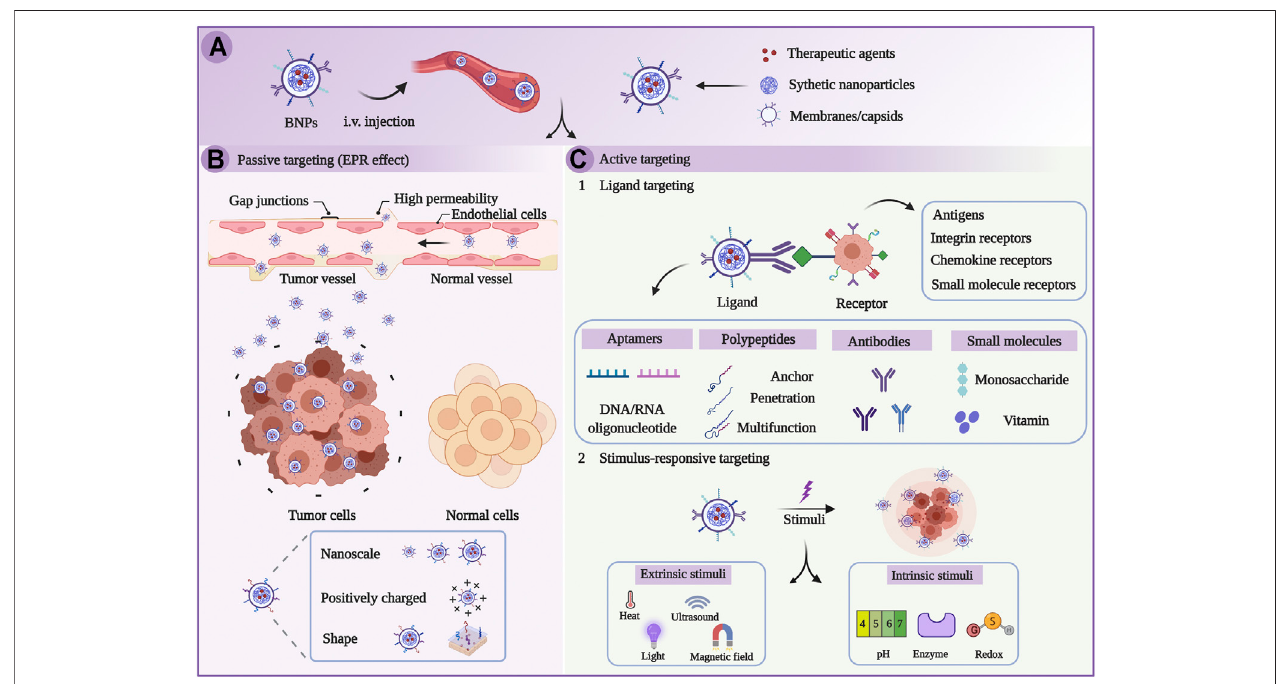
FIGURE 2 | Schematic illustration of targeted therapy on the basis of biomimetic nanoparticles (BNPs). (A) BNPs were injected intravenously. (B) BNPs passively target tumors through EPR effects. (C) BNPs actively target tumors through the stimulus-dependent and ligand-mediated pathway (Chen et al., 2021).